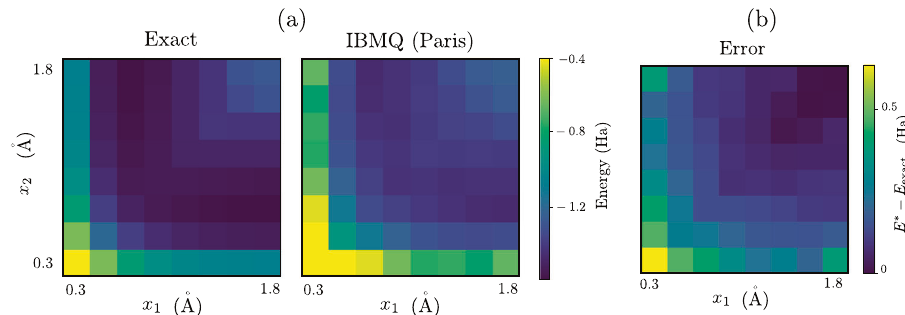
Fig. 4 Experimental application to a multi-dimensional problem. Ground state energies (in Hartree) for a linear chain of H 3 , over two- dimensional parameter space ( x 1 , x 2 ) where x 1 the distance between the fi rst and second H atoms and x 2 the distance between the second and third. a the exact ground state energy surface for an 8 × 8 grid of x 1 and x 2 values, compared to experimental results from running VQE + BOIS on from IBM ’ s Paris chip. The optimisations converged in ten iterations to compute the entire surface. b the error in the VQE + BOIS results, showing systematic offsets due to gate